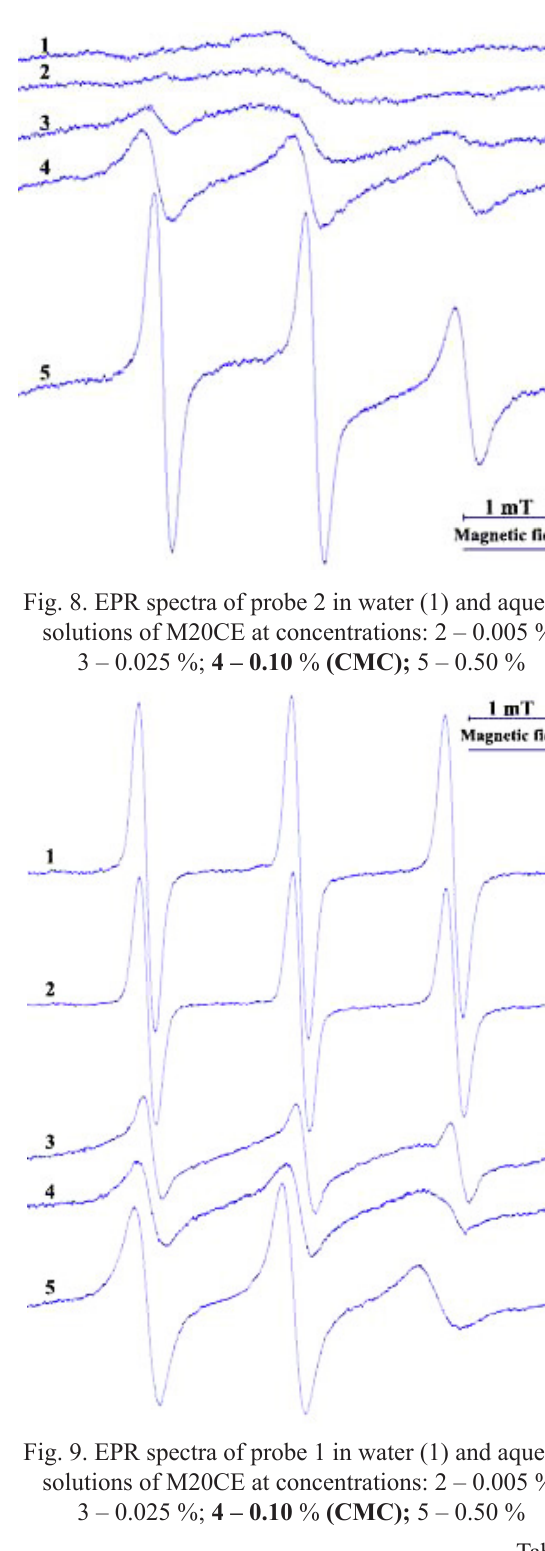
Some parameters of rotational diffusion of probe 1 in surfactant micelles С , surfactant